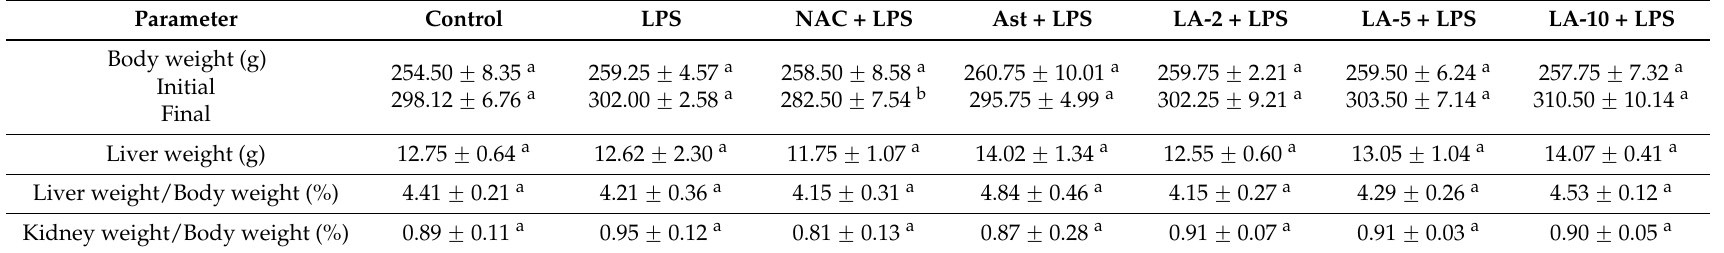
Table 1. The body and tissue weight measurements in each group 1